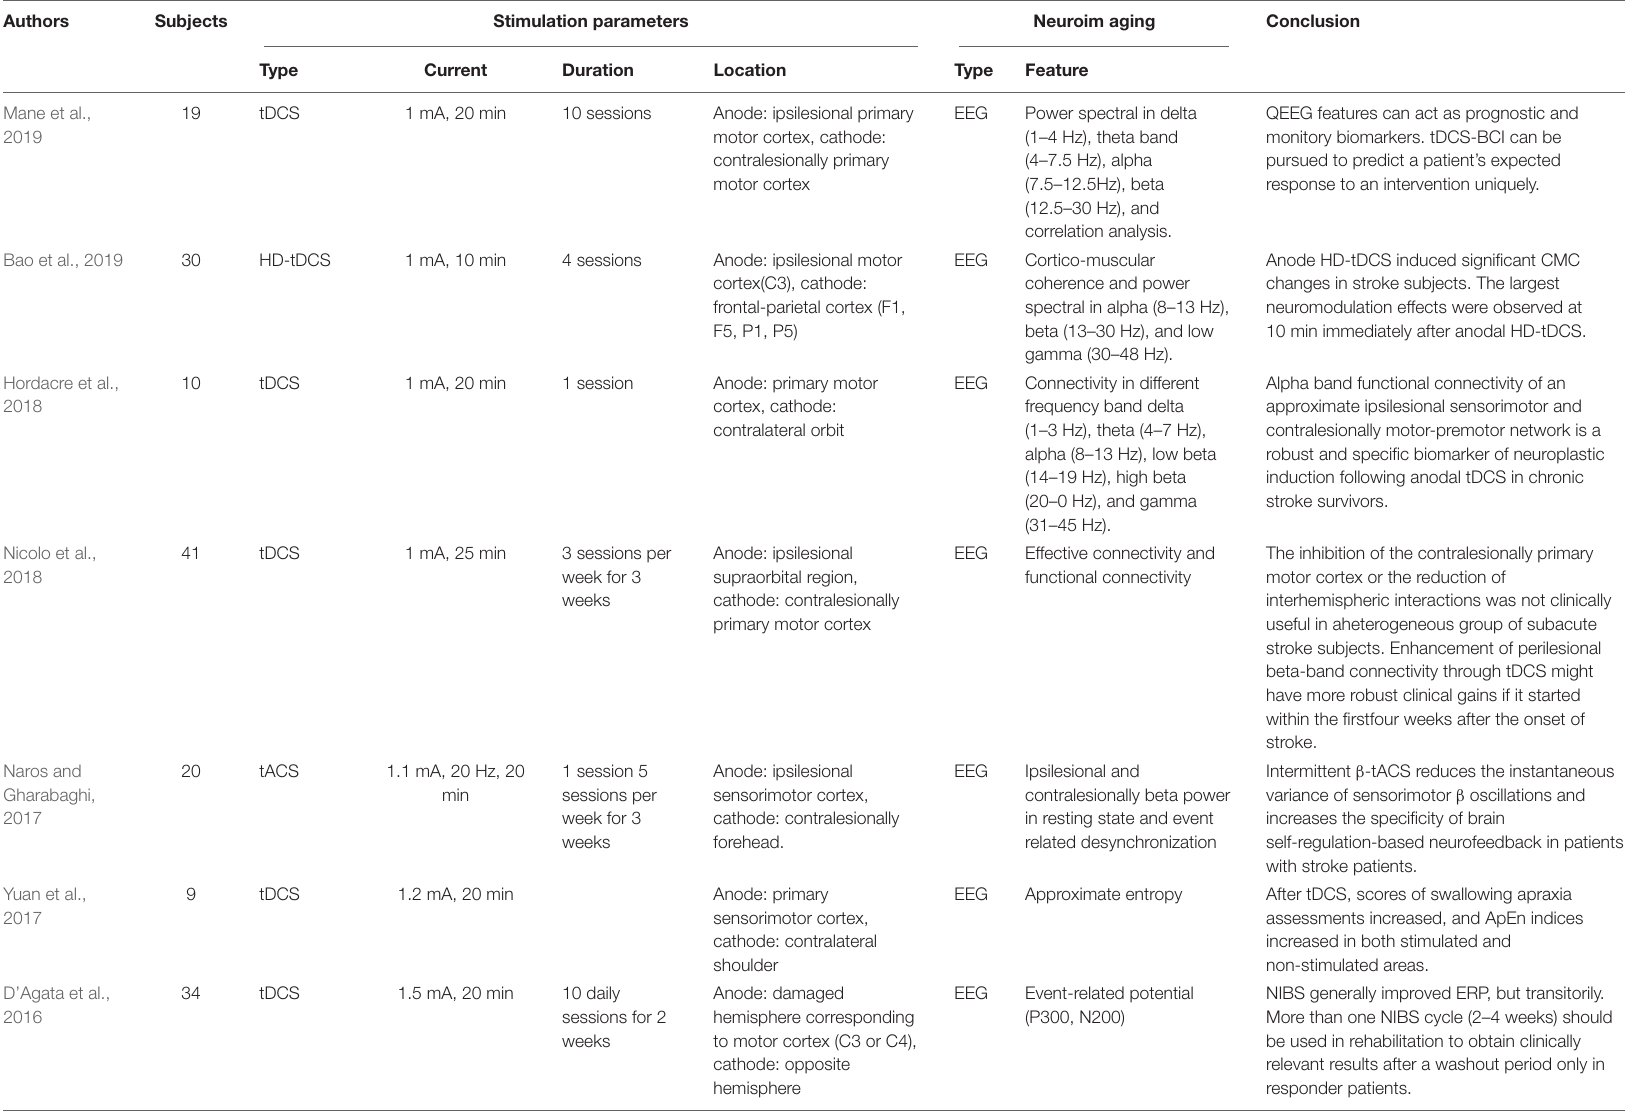
TABLE 8 | Studies and experimental characteristics of tES literature for